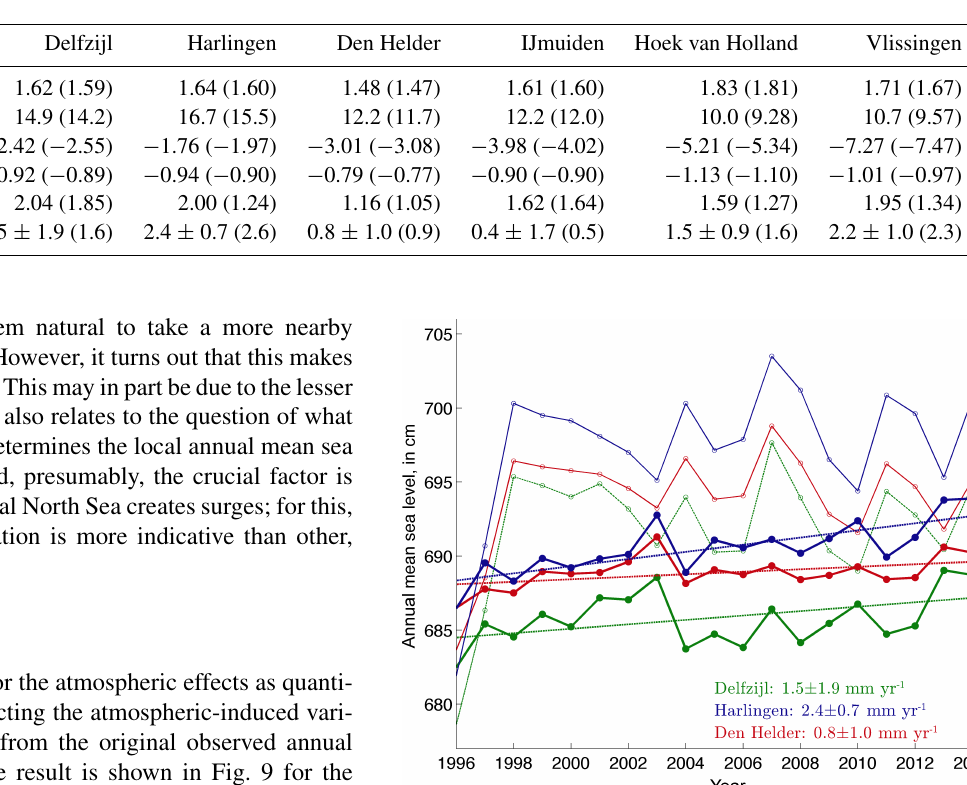
Table 2. Coefficients representing the effect of the wind climate and atmospheric pressure on annual mean sea level. Each is based on a combination of data from a tide gauge and Vlieland weather station. The root-mean-square error of the least squares fit is also listed. The trend with 95% confidence interval is obtained from linear regression after correcting observed annual mean sea levels for meteorological effects. In brackets, we list the results from an extended multiple regression in which time is included to allow for a direct estimate of the trend; this is discussed in Sect. 5.1.